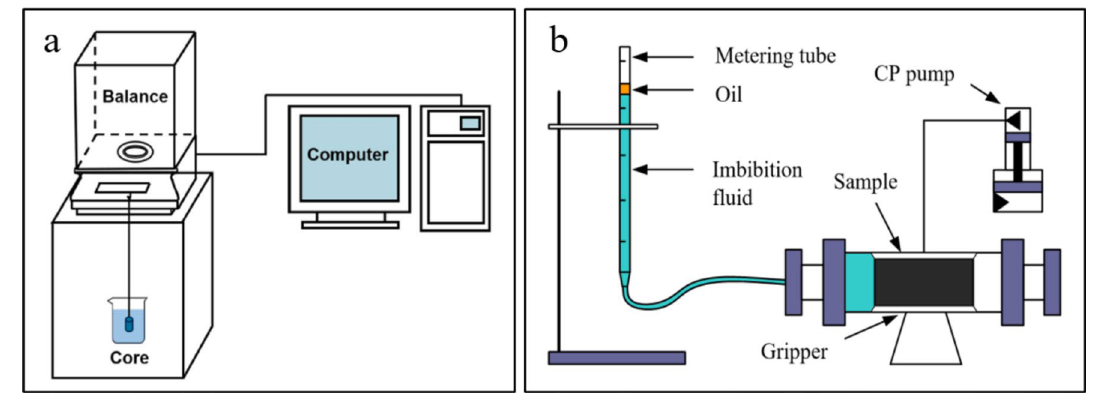
equipment) Table 3 Imbibition experimental design Material Experimental condition Experi- ment no.